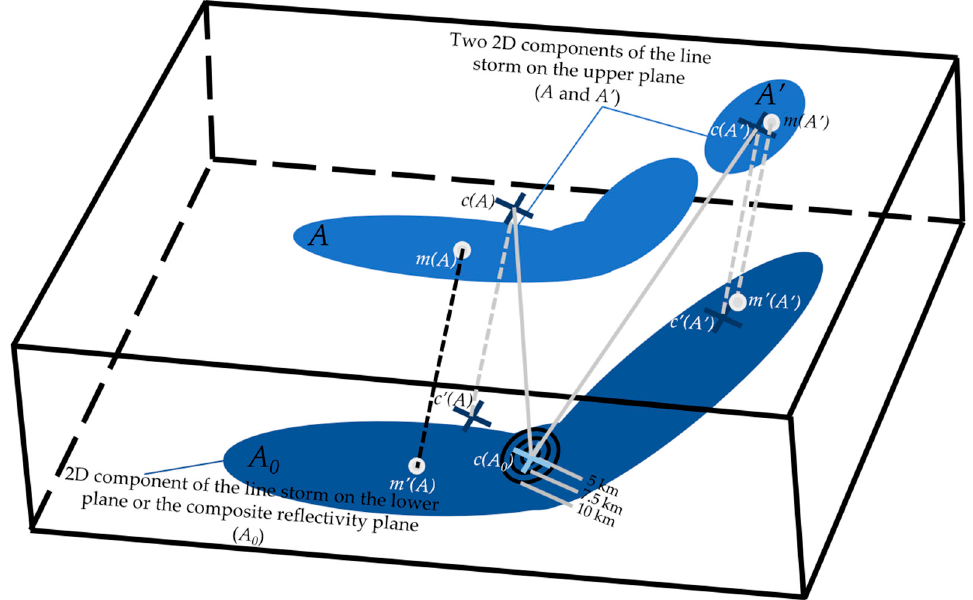
Figure 2. An example of a line storm under the new and old vertical association methods. Shaded areas ( A , A’ , and A 0 ) represent the 2D components of the line storm identified by the two reflectivity thresholds of 30 and 35 dBZ. The two components of A and A’ are both on the same upper plane. Component A 0 ideally represents the adjacent lower-plane component in the original identification method, while it indicates the composite reflectivity plane standard component in the new identifi- cation method. The blue cross points of c(A 0 ) , c(A) , and c’(A) , respectively, refer to the centroid of component A 0 , the centroid of component A , and its projection point on the plane of component A 0 . The white solid circle points of m(A) and m’(A) indicate the maximum reflectivity in the area of component A and its projection point on the plane of component A 0 , respectively. The three black circles of 5, 7.5, and 10 km are the search areas used in the old vertical association method.